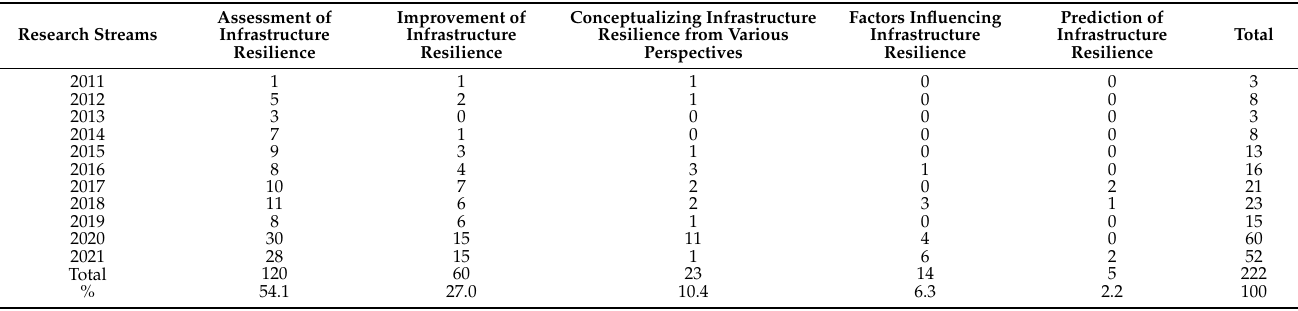
Table 6. Major research streams of infrastructure resilience